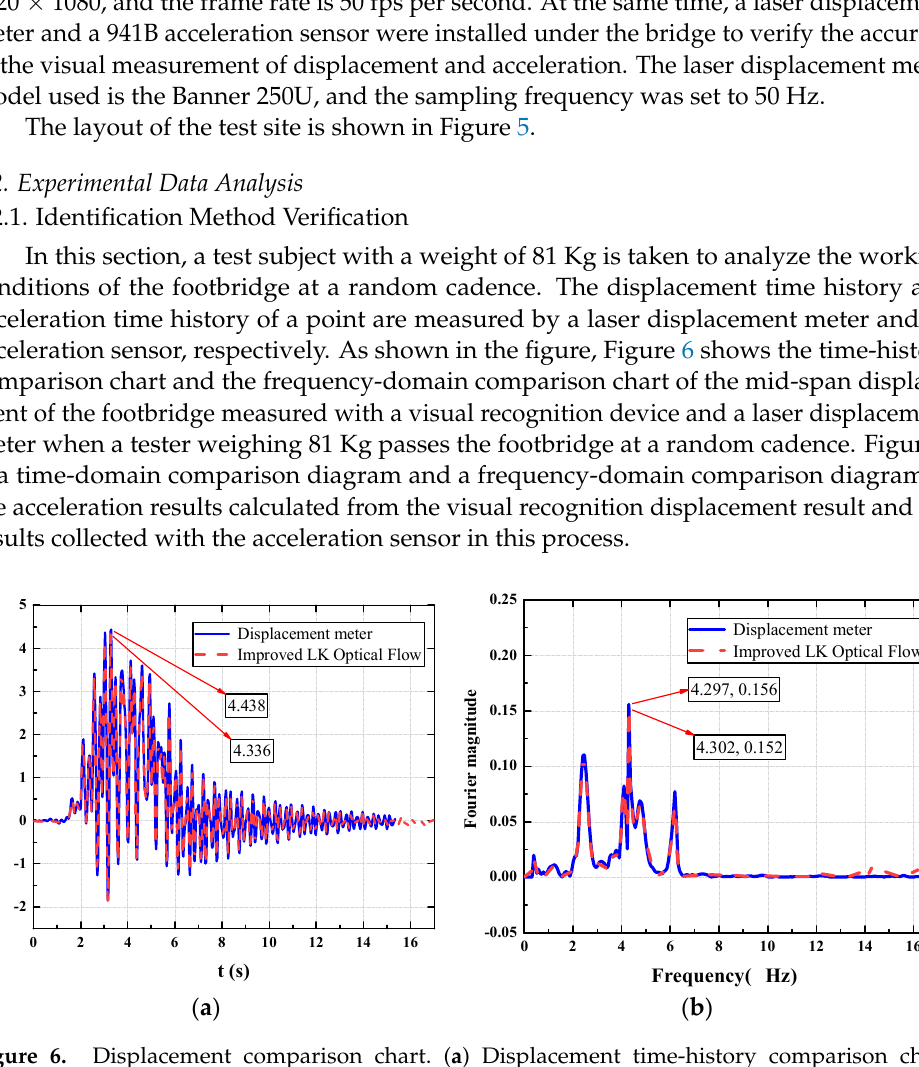
( b ) Figure 7. Acceleration comparison chart. ( a ) Acceleration time-domain comparison chart; ( b ) accel- eration frequency-domain comparison chart. 3.2.2. Pedestrian Detection We used the pedestrian detection algorithm mentioned in Section 2.2 to identify pe- destrians on the footbridge in the laboratory; the pixel position information of the